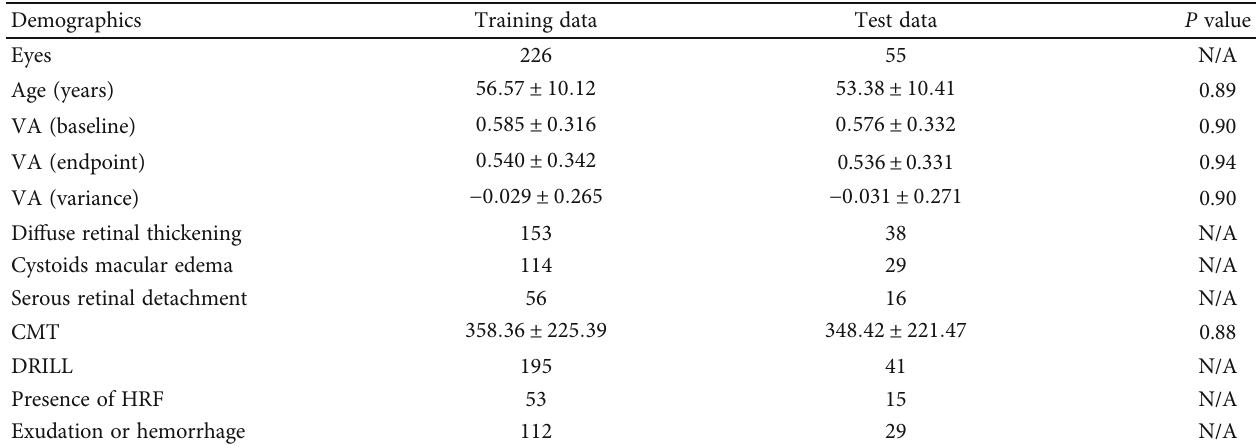
Table 1: Patient demographics.